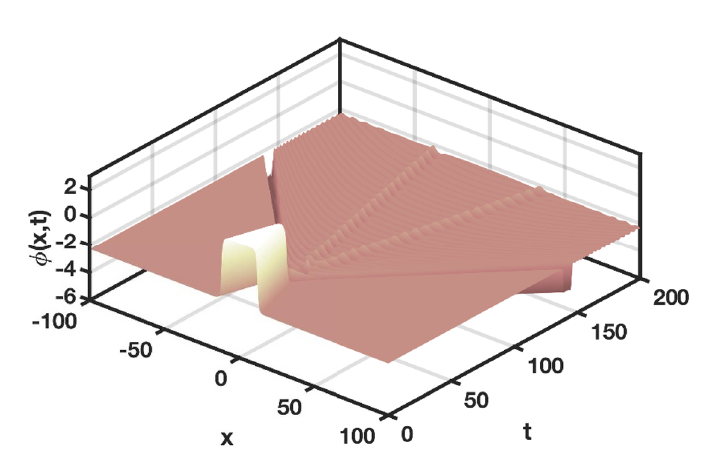
Figure 7 . Large kink-antikink collision for r = 0 . 65 with v = 0 . 3, showing the production of two thin small kink-antikink pairs and two propagating